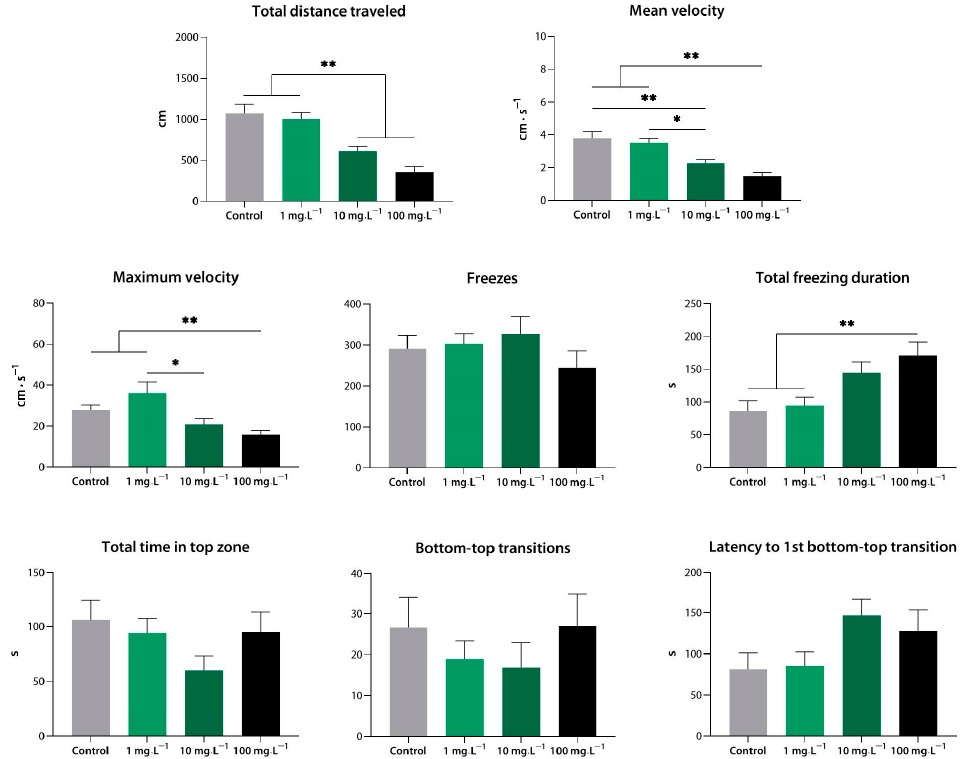
Figure 3. Compound 2 ( 9j ) induces sedation in zebrafish at a range of concentrations, as assessed using the novel tank test. *, p < 0.05; **, p < 0.01. 3.1.3. Sedative Activity of Compound 3 ( 9l ) in the Novel Tank Test Exhibiting a similar activity profile, compound 3 at 100 mg·L − 1 reduced the total dis- tance traveled, the mean and maximum velocity, and the number of transitions, and it increased the total freezing duration, as well as the latency of the first transition into the top zone compared to the control values ( p < 0.05, p < 0.01). Compound 3 at 10 mg·L − 1 reduced the mean velocity ( p < 0.05 vs. control), while the lowest concentration failed to exert any effects of its own and was significantly weaker than 10 and 100 mg·L − 1 ( p < 0.05, p < 0.01) (Figure 4).